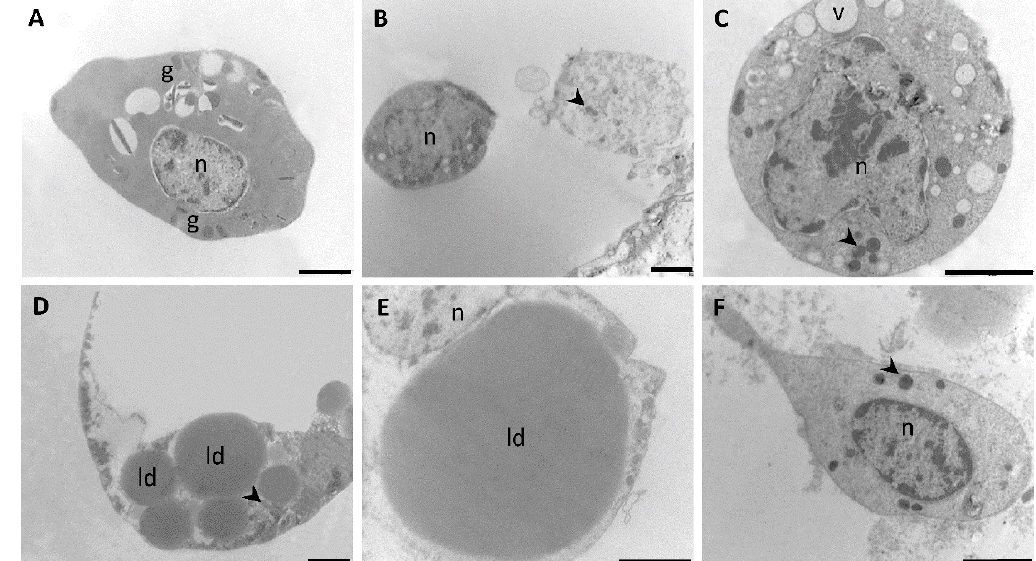
Figure 5. Transmission electron microscopy of different putative cell types of fifth instar nymphs of Dipetalogaster maxima . ( A ) granulocytes, ( B , C ) prohemocytes, ( D , E ) adipohemocytes and ( F ) oenocytes. Arrowheads indicate mitochondria; n, nucleus; ld, lipid droplet; g, granules. Bars: 2 μ m for ( A – D ) and 5 μ m for ( E , F ).